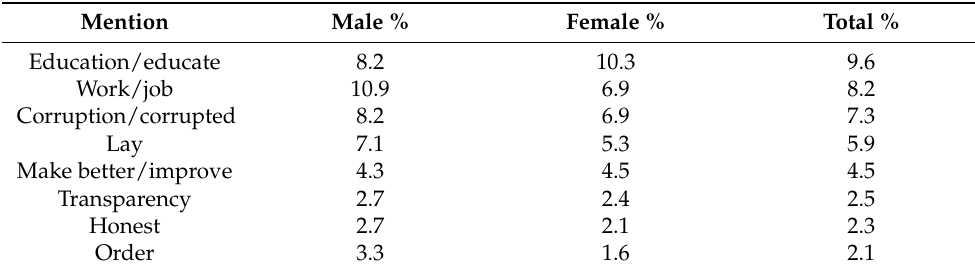
Table 9. Words associated with solution to the crisis.